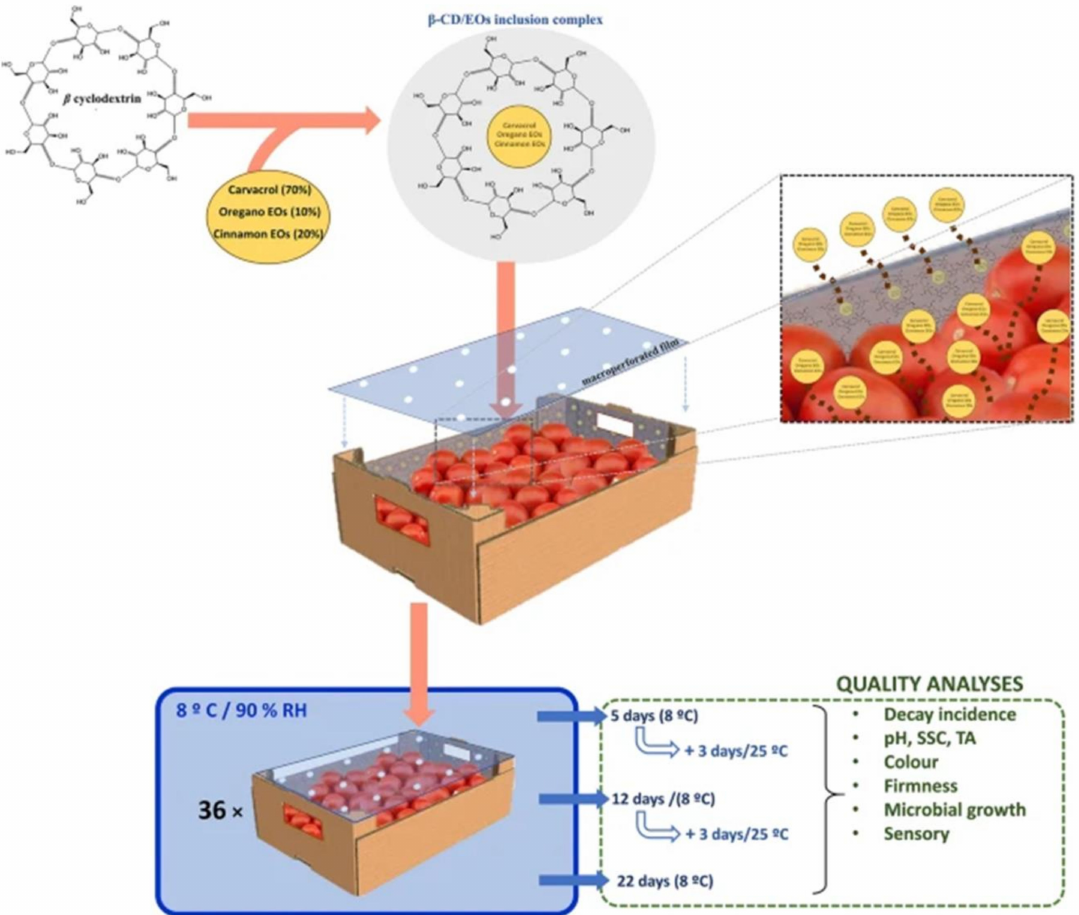
Figure 3. Application of essential oil- β -CD molecular inclusion complexes for the preparation of an active cardboard packaging for food storage (Reproduced from